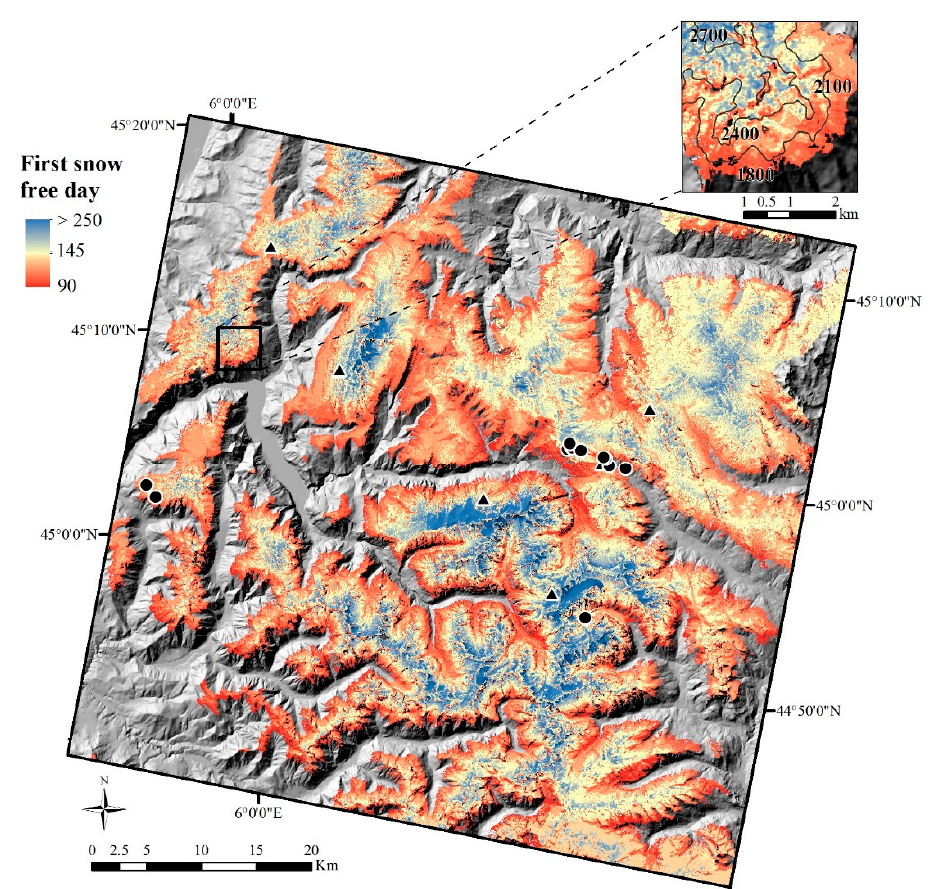
Figure 8. The first snow free day estimated using SPOT-5 and Landsat-8 imagery for 2015, expressed in Julian Days. Pixels have a 25 m spatial resolution and correspond to alpine areas above 1800 m a.s.l.. Points show the location of soil temperature loggers (circles) and snow height monitoring stations (triangles). The inset shows variation in snow cover duration relative to elevation isolines.